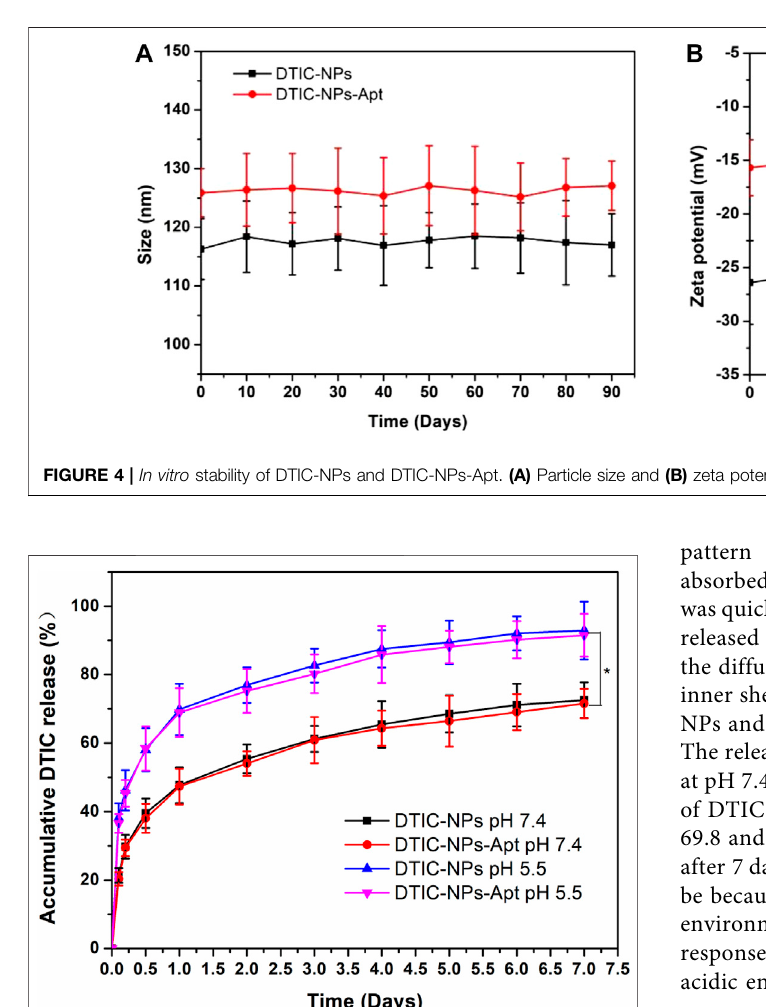
Frontiers in Bioengineering and Biotechnology |